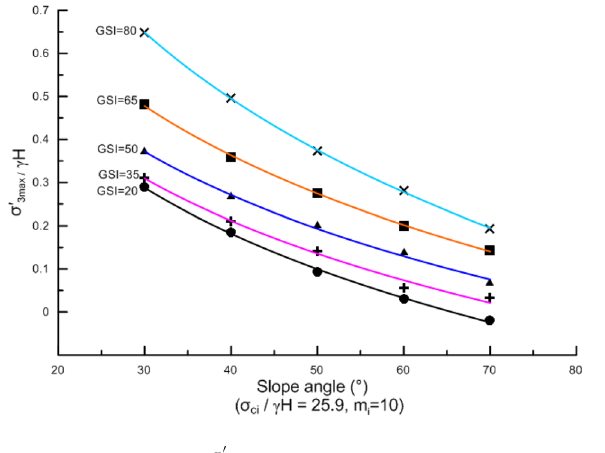
σ ′ 3,max γ H with slope angle.